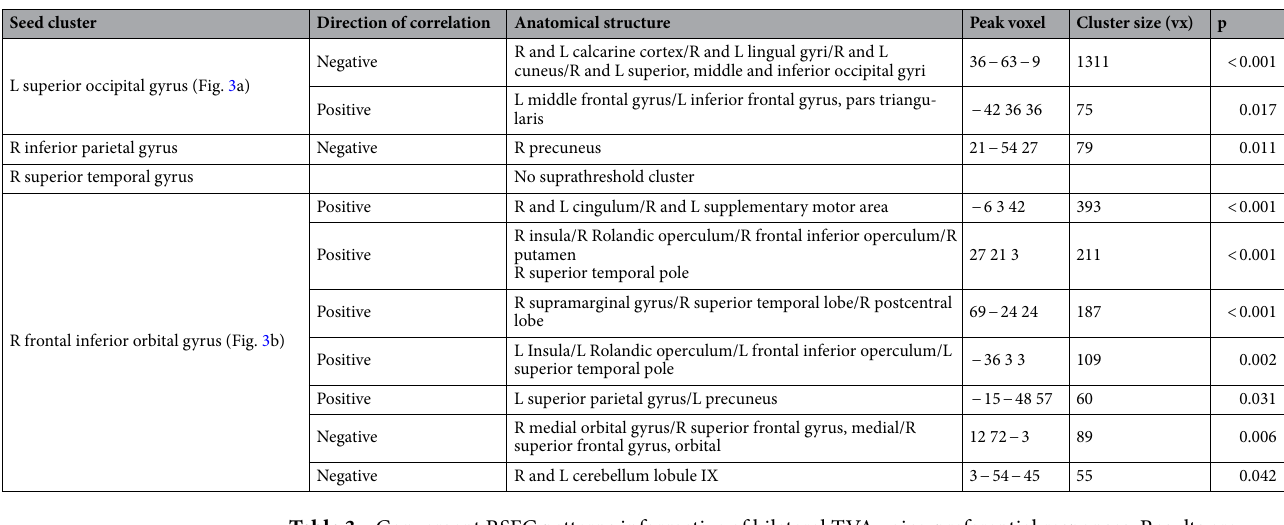
Table 4. Number of intramodal convergent RSFC clusters using the MVPA clusters with the RSFC correlates of individual voice-preferential responses in the right and left TVA. Results are shown at a voxel-wise threshold of p < 0.001 and whole brain FWE-corrected at cluster level with a cluster threshold of p < 0.05. R right, L left. Voice-preferentiality is encoded in bold and italics. The bold signifies significant clusters between the corresponding right and left TVA region, italics between different TVA regions. Voxel size 3 × 3 × 4 mm 3